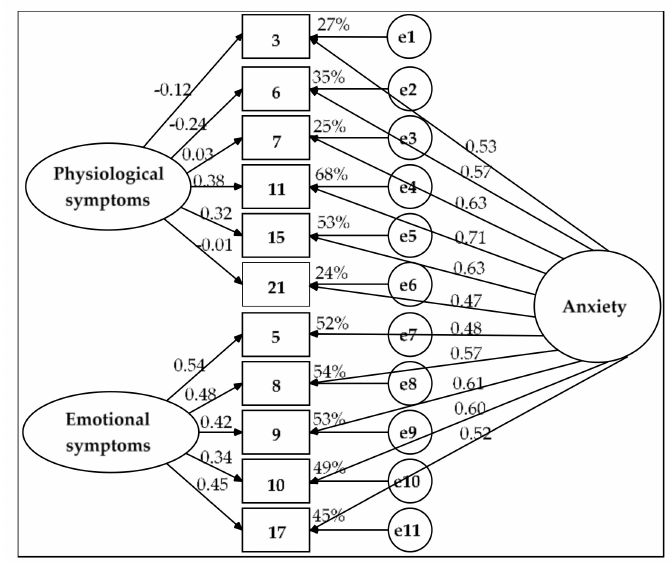
Figure3. BifactormodelestimatedbytheMLmethodinthesubsampleof219participants. Measurement residuals: e1 to